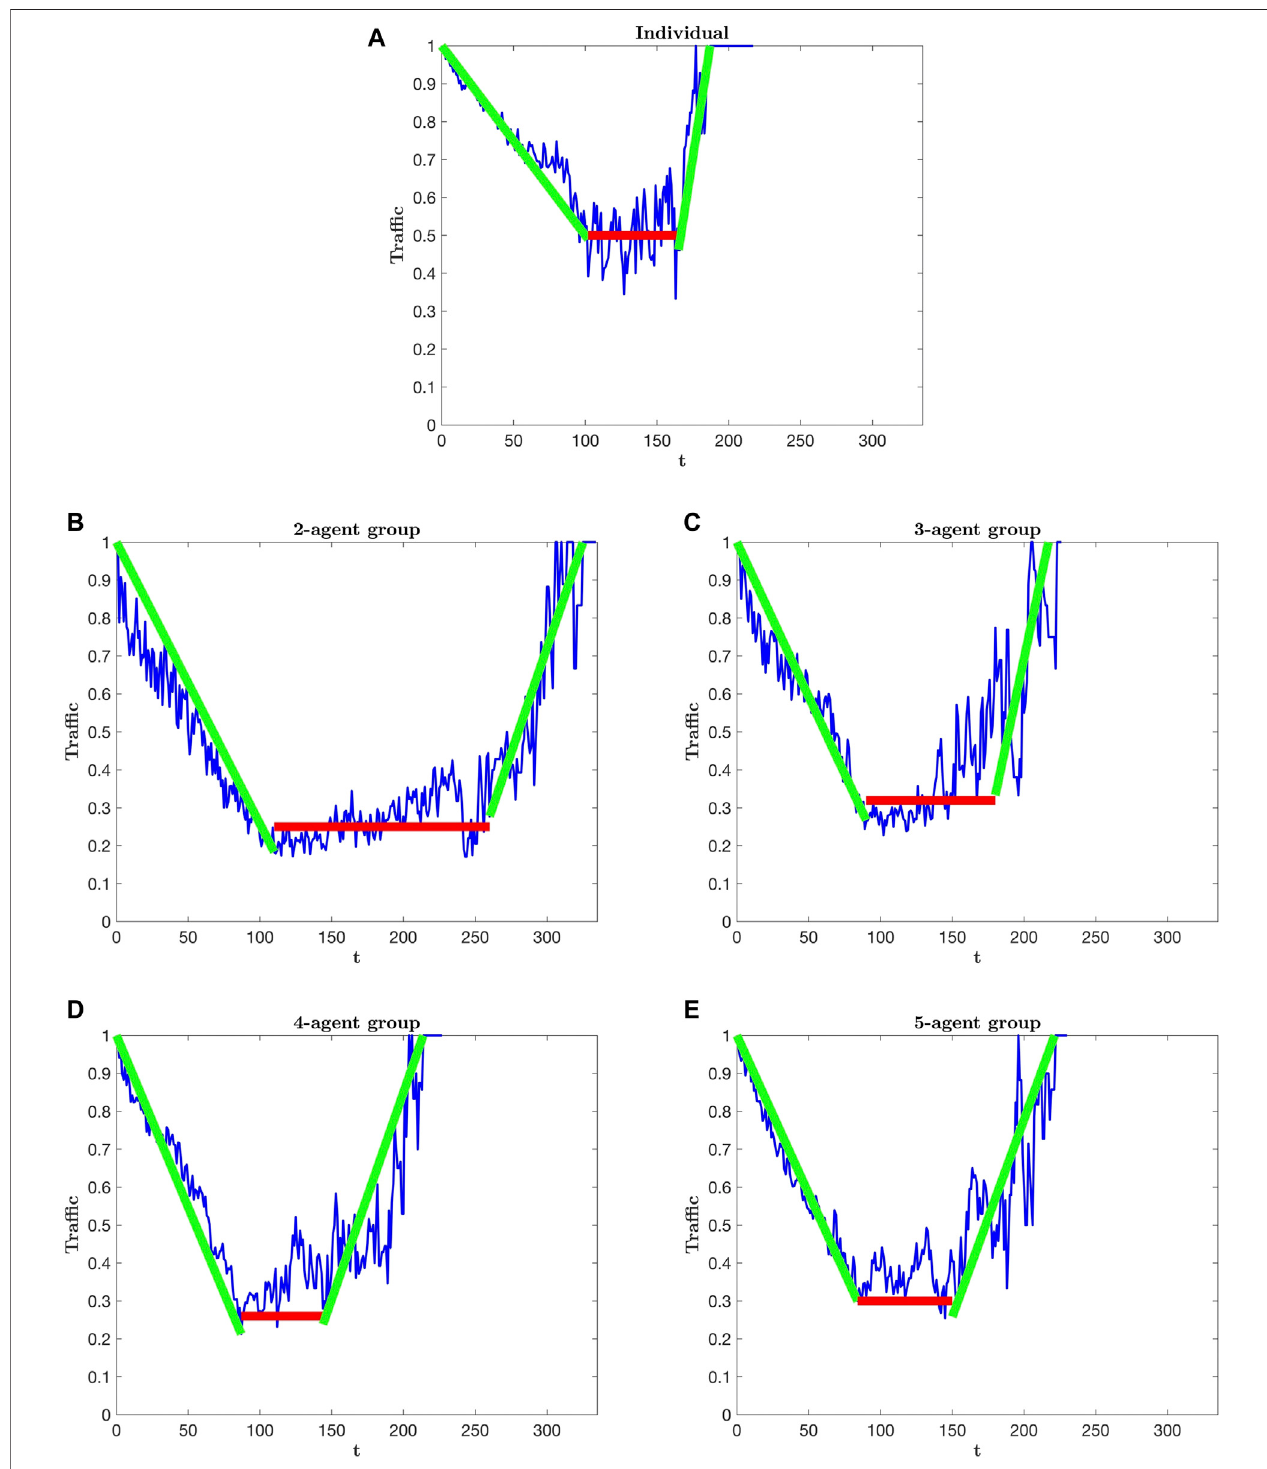
FIGURE6 | Timeevolutions of traf fi c.For each type ofgroup (A – E) , durations ofthe movable (time span ofthe left green line), jammed (time span of themiddle red line) and rare fi ed phases (time span of the right green line) can be identi fi ed through drawing approximately the gradient of traf fi c changes.